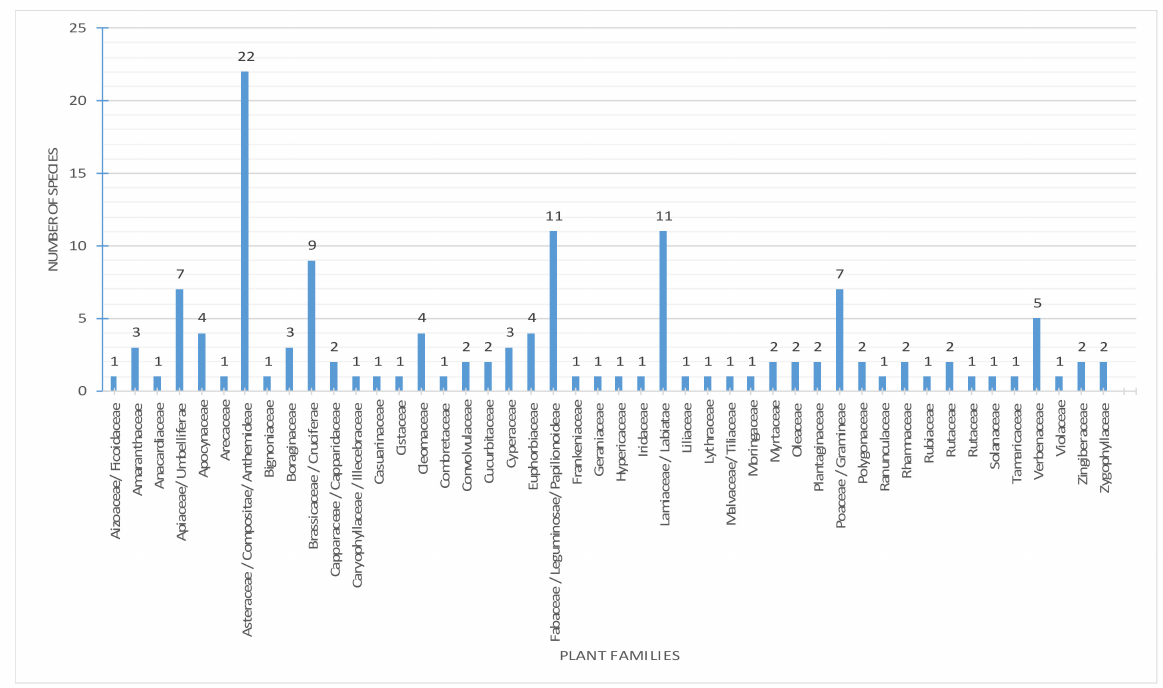
Figure 1. Families of EO-bearing plant species in the